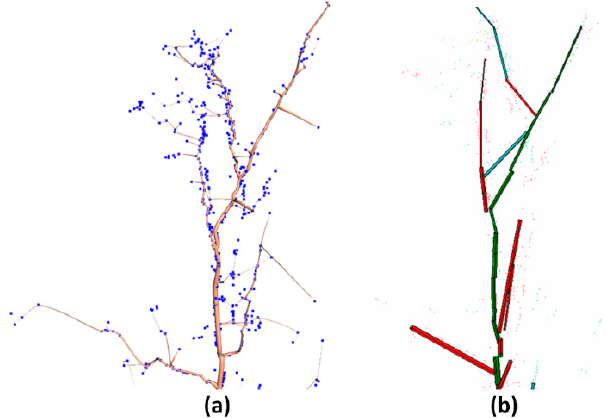
Figure 15. Comparison of reconstruction results of a Chinese scholartree crown. ( a ) Input point cloud of a tree; ( b ) our model; ( c ) reconstruction of tree crown based on TreeQSM.